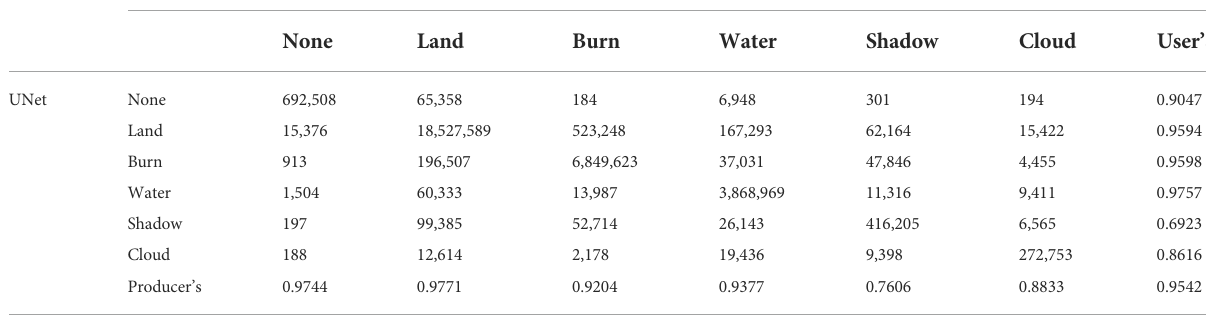
TABLE 2 UNet Model Error Matrix based on a 75/25 train/test split of hand labelled MSS images. Label